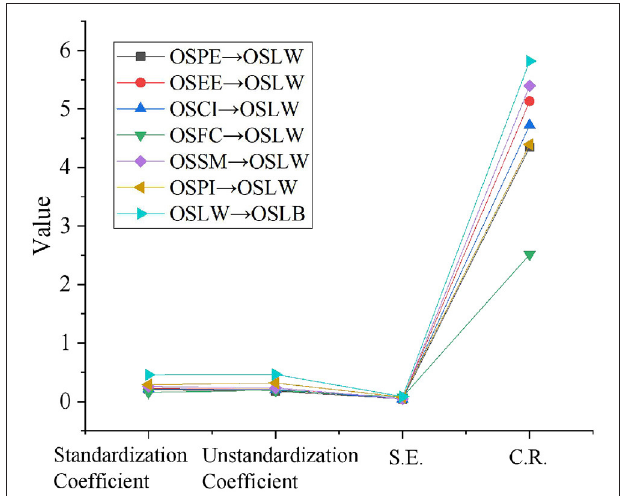
FIGURE 6 | Corrected path analysis results.